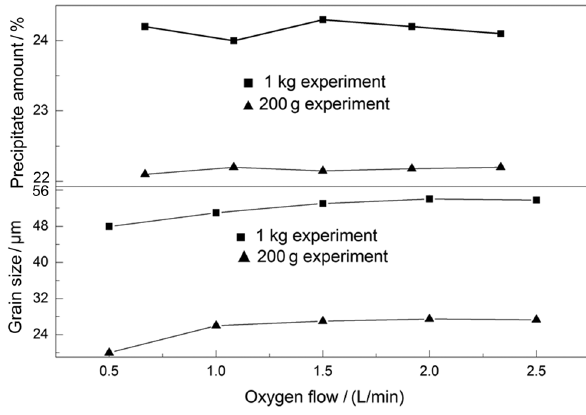
Figure 15: Precipitate amount and average grain size of rutile versus oxygen flow.